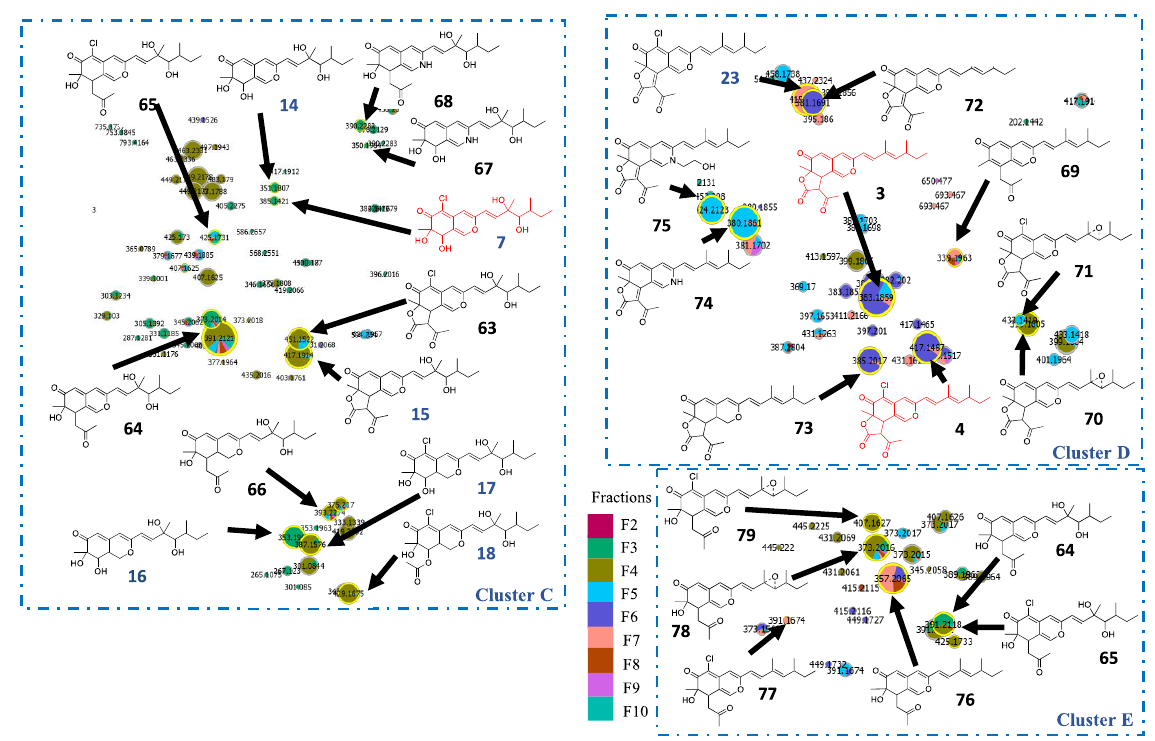
Figure 6. Annotation of clusters C, D and E with hypothetical structures proposed from molecular network data. In red and blue are molecules (ochrephilone ( 3 ), isochromophilone I ( 4 ) hypocrellone A ( 7 ), geumsanol A-C and G ( 14 – 17) and eupeniazaphilone C ( 18 ), 5-chloroisorotiorin ( 23 )) identified directly in MN, in black are molecules annotated with MS/MS.